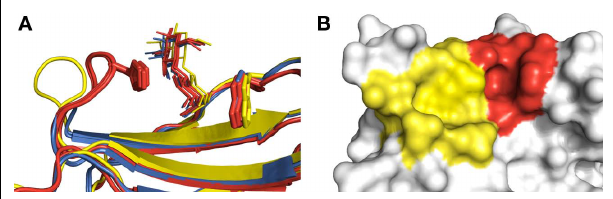
FIGURE 1 | Structural aspects of ligand recognition by galectins. (A) Galectin-1 (PDB codes 1GZW, 1W6O, 1W6P, and 2ZKN, shown in red) features a loop with a histidine residue (His52) which associates closely with the ligand.The terminal galactose is bound between this histidine and an opposite-facing tryptophan (Trp68), effectively sandwiched between the two residues. Galectin-3 (PDB code 1KJL, shown in yellow) does not feature the histidine residue, and the loop does not closely associate with the ligand. In galectin-7 (PDB codes 4GAL and 5GAL, shown in blue), the loop is considerably shortened from that of galectin-1 and galectin-3. (B) Surface view of galectin-3, highlighting the crystallographically observed binding site (red) and the alternative site to which ligands were typically docked (yellow). Galectins-1 and 7 feature similar alternative sites. All structures rendered using PyMOL. For figure (A) , structures were overlaid using